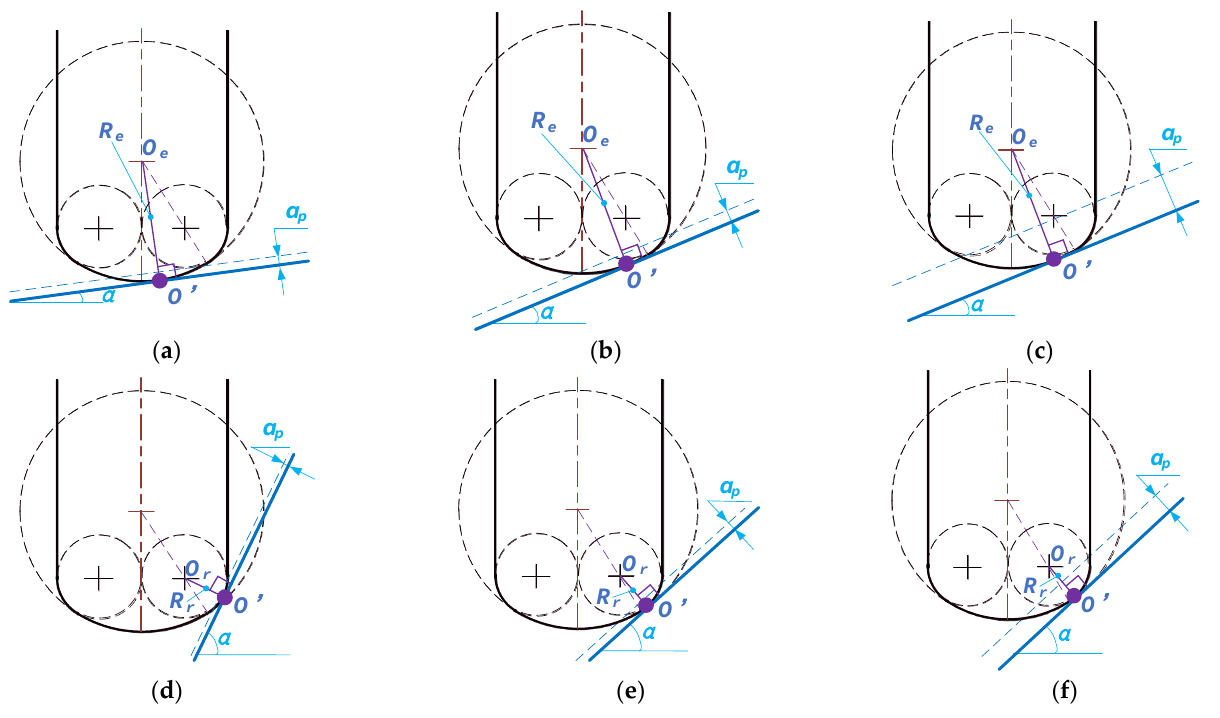
Figure 5. Schematic diagrams of cutting modes of DACT: ( a ) O’ is located on L e , and only L e is involved in cutting; ( b ) O’ is located on L e , and L e and L r participate in cutting; ( c ) O’ is located on L e , and L e , L r , and the peripheral cutting edge participate in cutting simultaneously; ( d ) O’ is located on L r , and only L r is involved in cutting; ( e ) O’ is located on L r , and L r and the peripheral cutting edge participate in cutting; ( f ) O’ is located on L r , and L e , L r , and the peripheral cutting edge participate in cutting simultaneously.